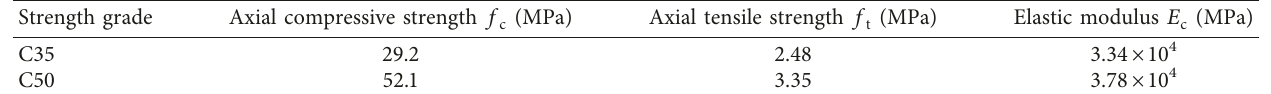
Table 5: Material properties of concrete.